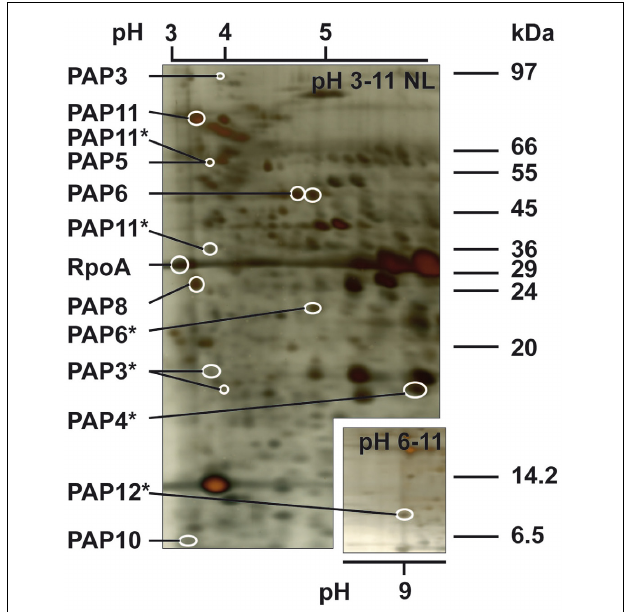
FIGURE 4 | Essential polymerase-associated proteins (PAPs) of the soluble PEP complex. Positions of PAPs in the 2D gel after isoelectric focussing of the PC fraction on a pH 3–11NL and pH 6–11 gradient. Spot identity is given at the right margin. Fragments are additionally indicated by an asterisk. Marker sizes and pH range are given at right margin and above or below the gel, respectively. The gel is